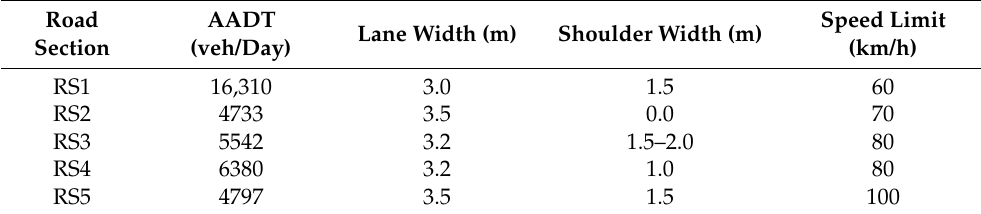
have (see Table 1): different lane and shoulder width, colored or uncolored shoulder, different AADT (Average Annual Daily Traffic). Table 1. Two-lane rural road characteristics. Table 1. Two-lane rural road